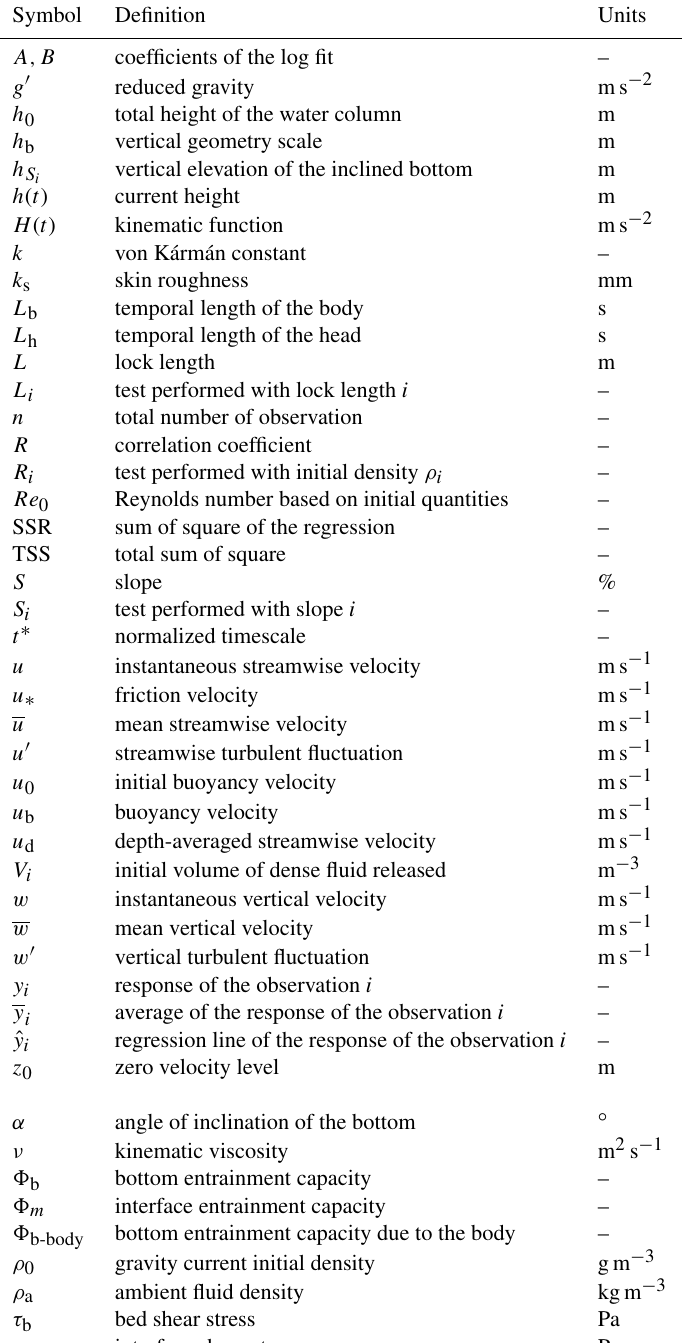
Table A1. List of symbols with definition and unit of